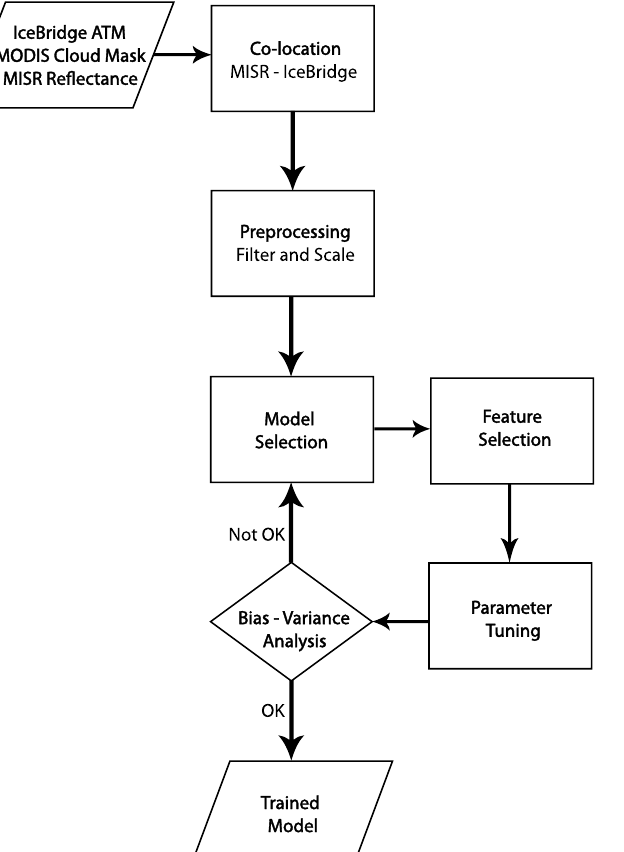
Figure 3. A process diagram illustrating the workflow method used in model generation. Note that the model selection, feature selection, and hyper-parameterisation constitutes an iterative process that converges on a final hyper-parameterised model and feature subset via cross validation and bias-variance analysis.